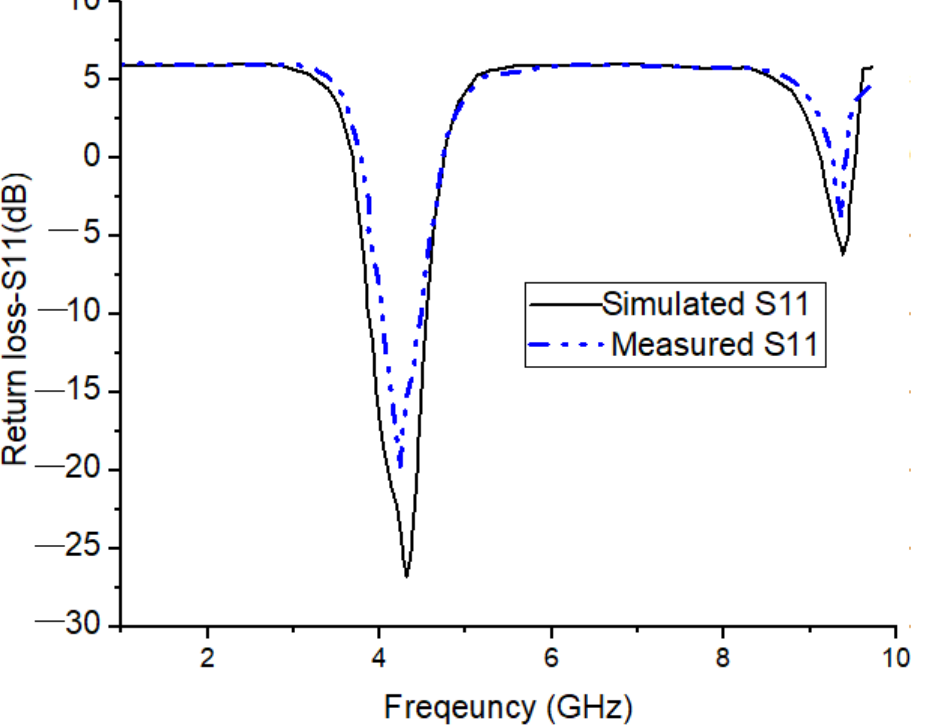
Figure 11. Comparative analysis of measured and simulated return loss of resonance cavity resonator. Insertion loss is nothing but a loss of signal energy/power from the transmission line